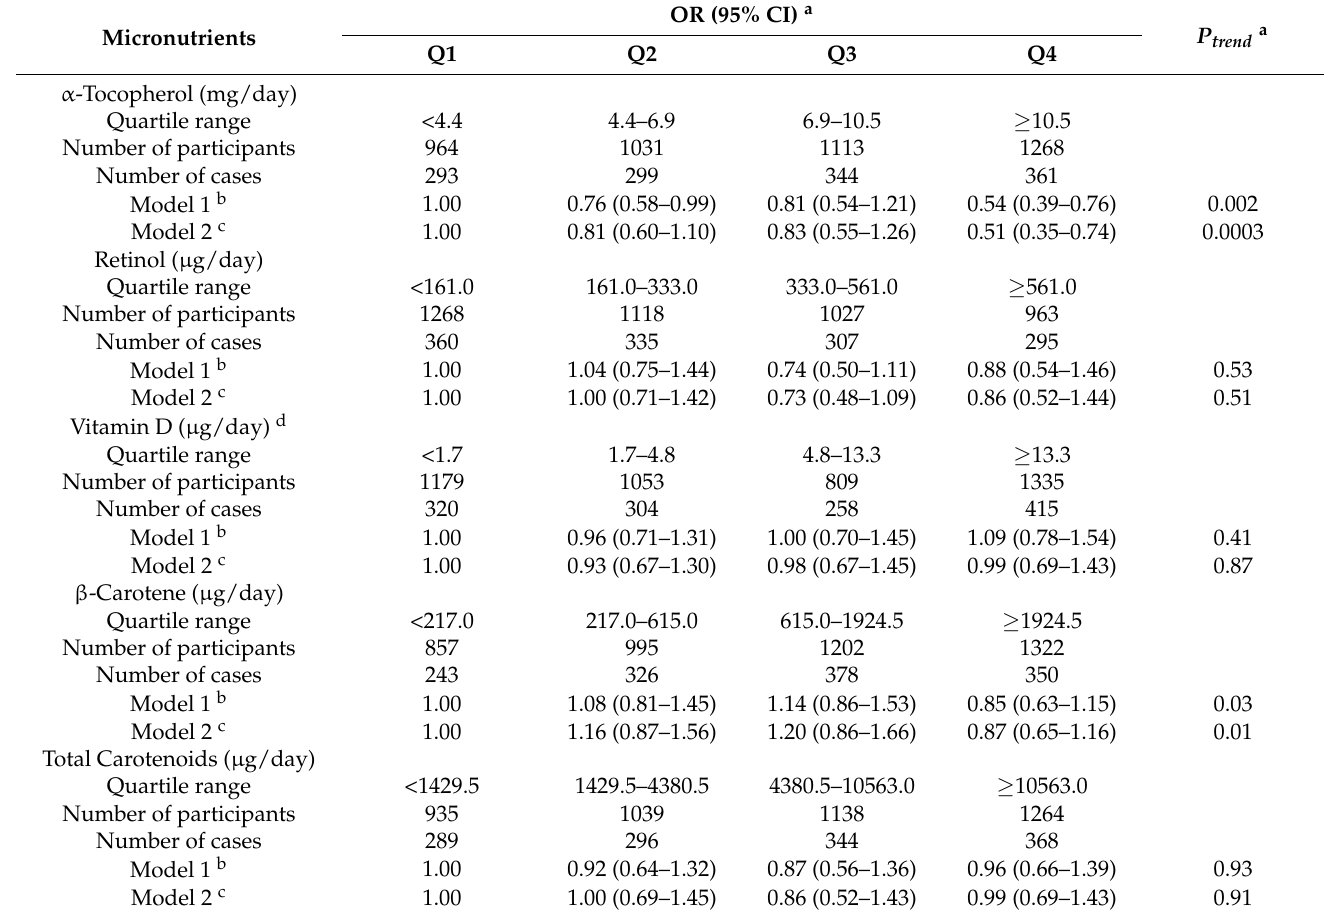
Table 2. Overall Odds Ratio and 95% Confidence Interval for Hepatic Steatosis by Quartiles (Q1-Q4) of Dietary Micronutrients.